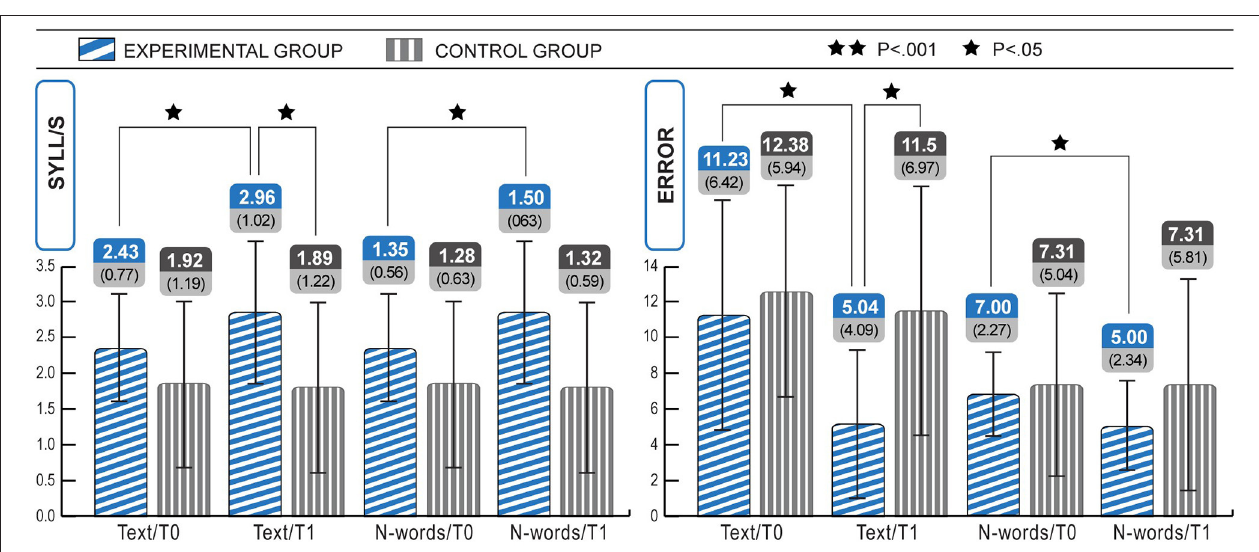
FIGURE 2 | Within and between group analyses show significant increases in speed (text and non-words) and accuracy (text and non-words) of reading in the Experimental group, from T0 to T1. Statistical differences are marked according to the p -values at Wilcoxon test on Z scores. The change in speed text was 607% higher than expected in the experimental